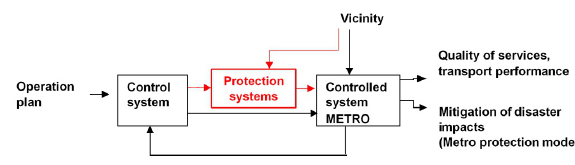
Figure 5. It is very complex distributed system that involves controlled, control and protection subsystems, their interdependences, operation states and condi- tions.